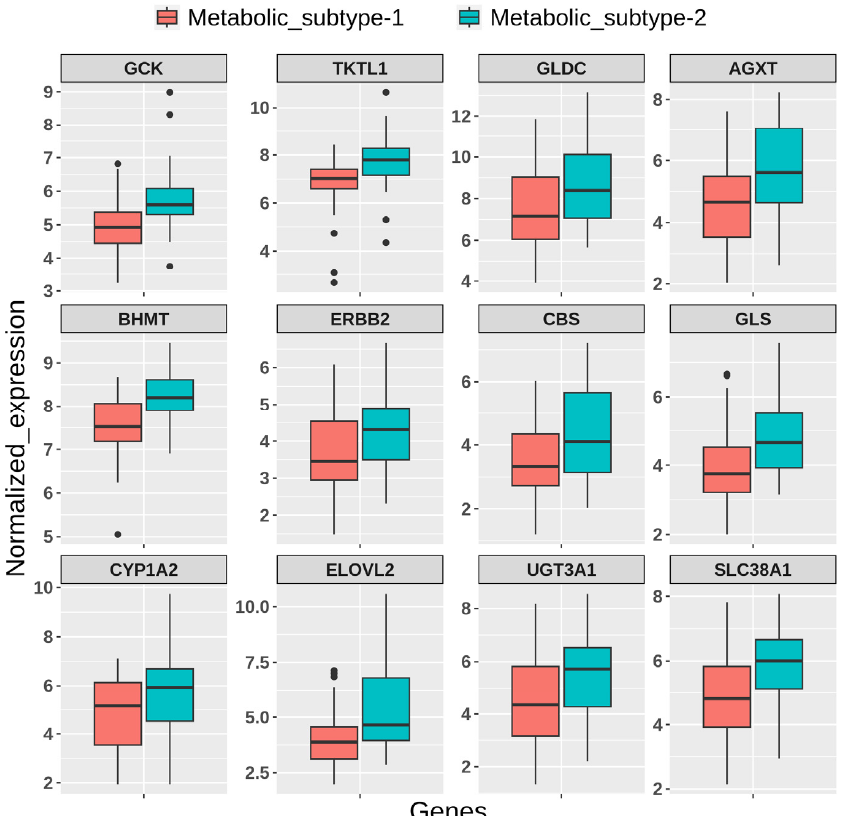
Figure 10. Boxplot showing the expression pattern of candidate genes between metabolic subtypes identified in the GEO validation dataset.